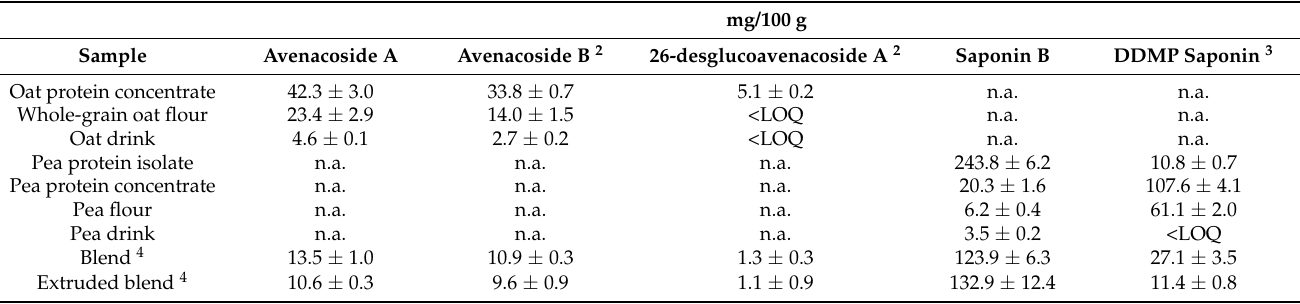
Table 5. Contents of saponins in different food samples 1